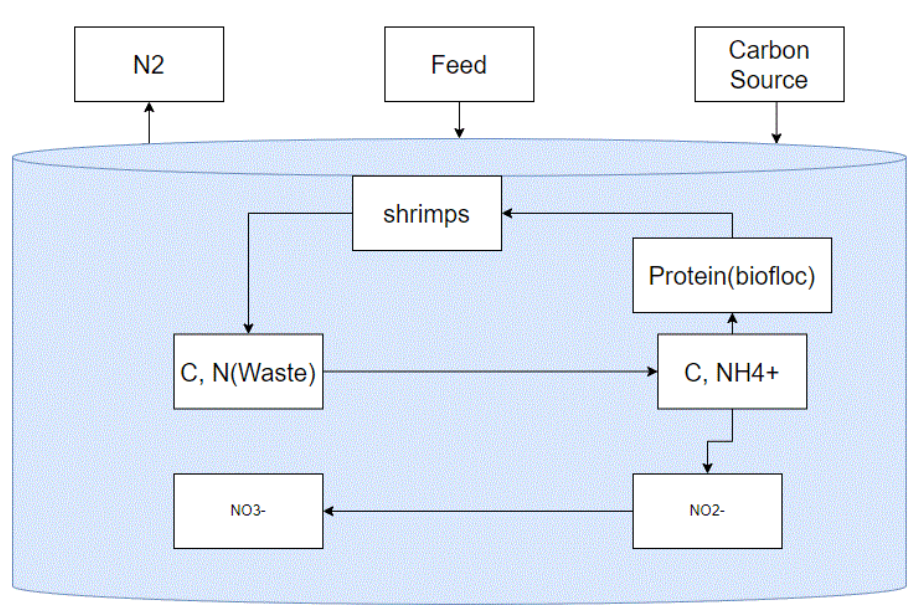
Figure 7. Shrimp farm in Sahara Desert with Biofloc technology.